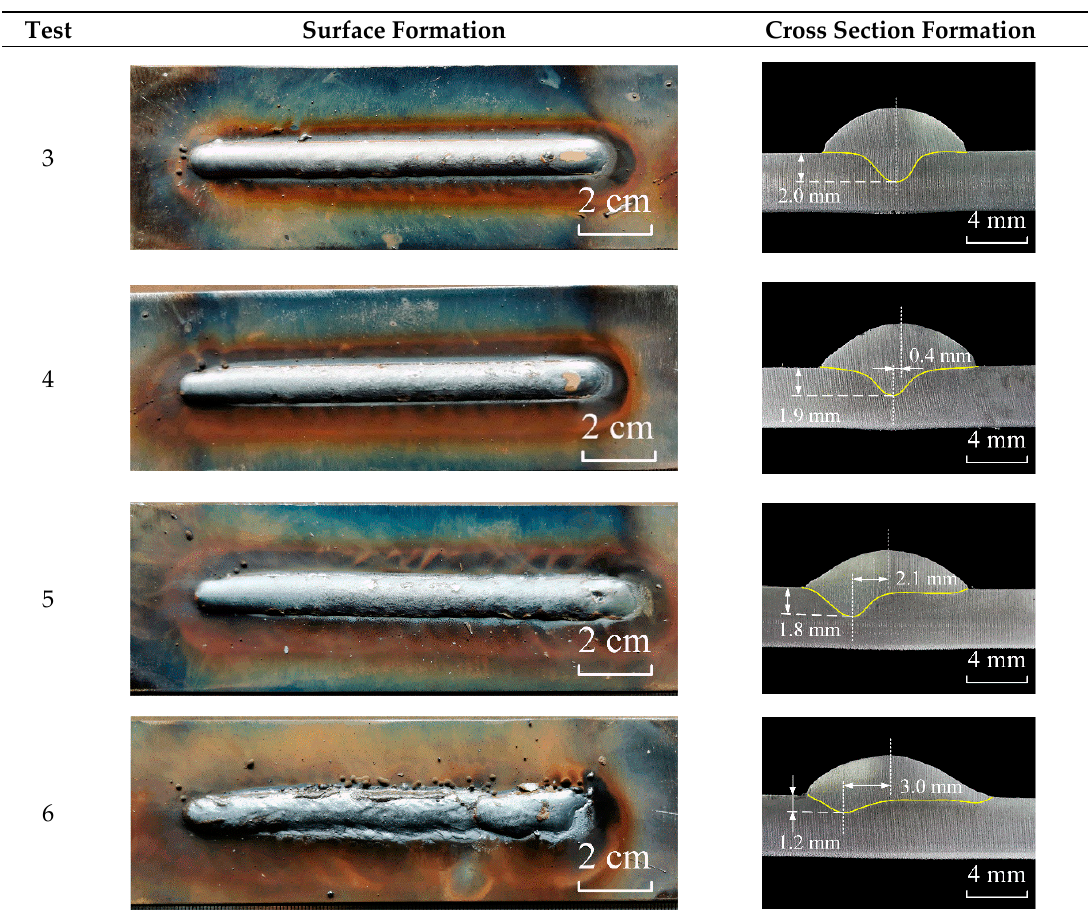
Figure 8. The formation of weld bead in the projected transfer zone. Metals 2020 , 10 , x FOR PEER REVIEW